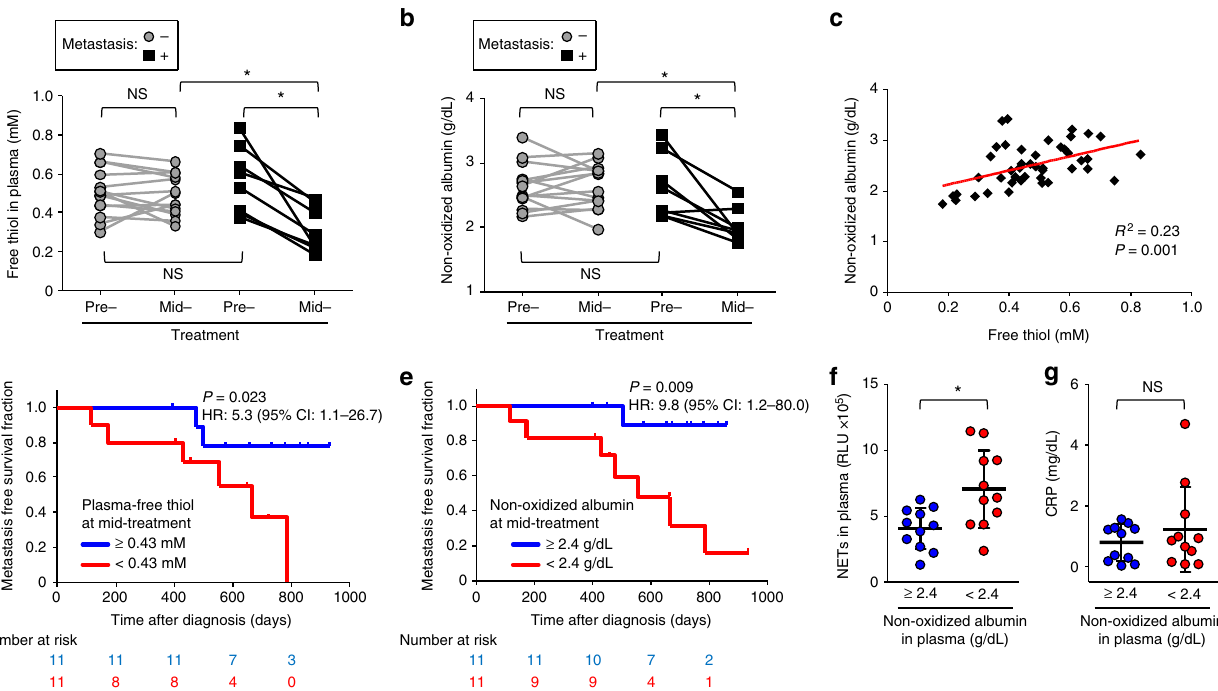
Fig. 5 Plasma redox imbalance, NETs, and metastasis in human cancer. a – g Pre-treatment and mid-treatment plasma samples from HNSCC patients who developed lung metastasis (Metastasis + ; n = 8) and matched control patients without metastasis (Metastasis – ; n = 14) were analyzed for free thiol ( a ), and non-oxidized albumin ( b ) concentration. c Relationship between the concentration of plasma free thiol and non-oxidized albumin. The correlation between plasma free thiol and non-oxidized albumin was analyzed ( n = 44, Pearson ’ s correlation coef fi cient test, R 2 = 0.23, p = 0.001). d , e Kaplan – Meier analysis of lung metastasis-free survival in the entire cohort strati fi ed by the median values of plasma free thiol ( d ), and non-oxidized albumin ( e ) concentration at mid-treatment (hazard ratio = 5.3 [95% CI 1.1 – 26.7] and 9.8 [95% CI 1.2 – 80.0], respectively; log-rank p = 0.023 and 0.009, respectively) ( f , g ) Plasma level of NETs ( f ) and CRP ( g ) in the HNSCC patient cohort strati fi ed by the median values of non-oxidized albumin. The data are individual values with the mean ± s.d. ( n = 11 in each group). * P < 0.05 by ( a , b ) repeated-measures ANOVA for split-plot designs and ( f , g ) Student ’ s t - test, NS not signi fi